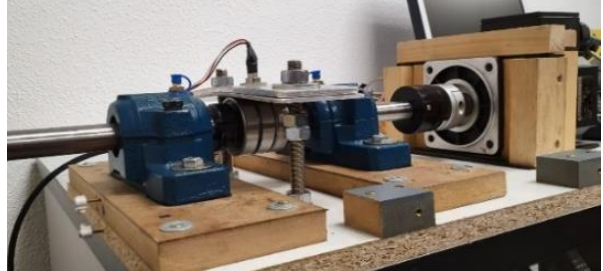
Figure 6. Bearing test bench.